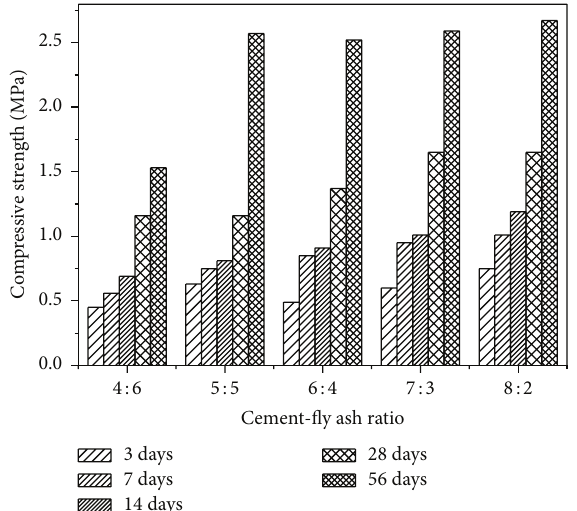
Figure 6: Compressive strength of cemented solidified fly